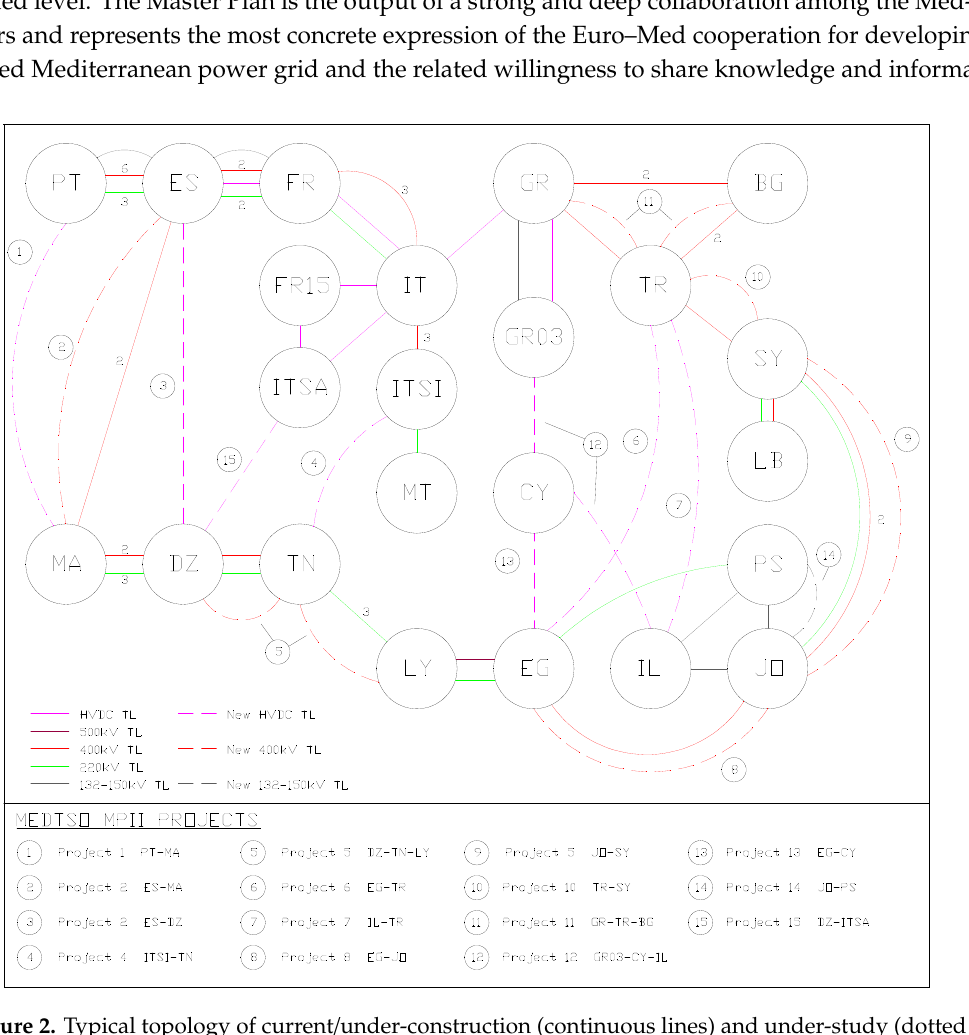
Figure 2. Typical topology of current / under-construction (continuous lines) and under-study (dotted lines) interconnections between Med-TSO members.